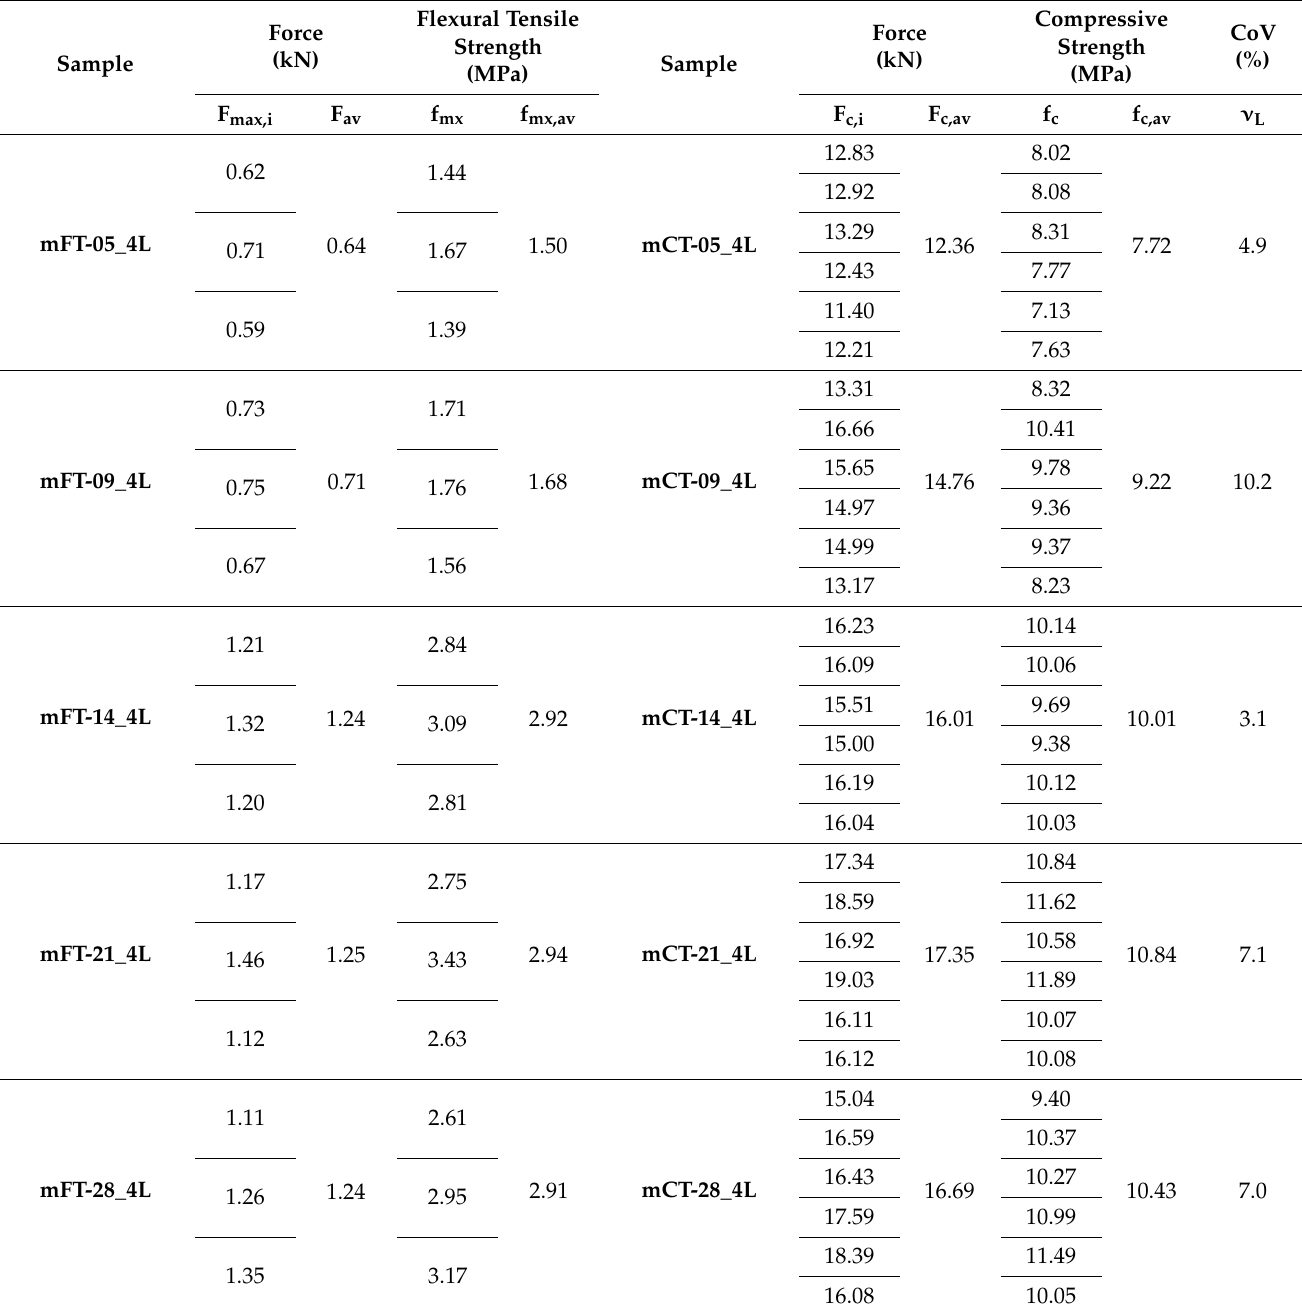
Table 2. Flexural and compressive strengths—mortar made with 4 L of mixing water per 25 kg